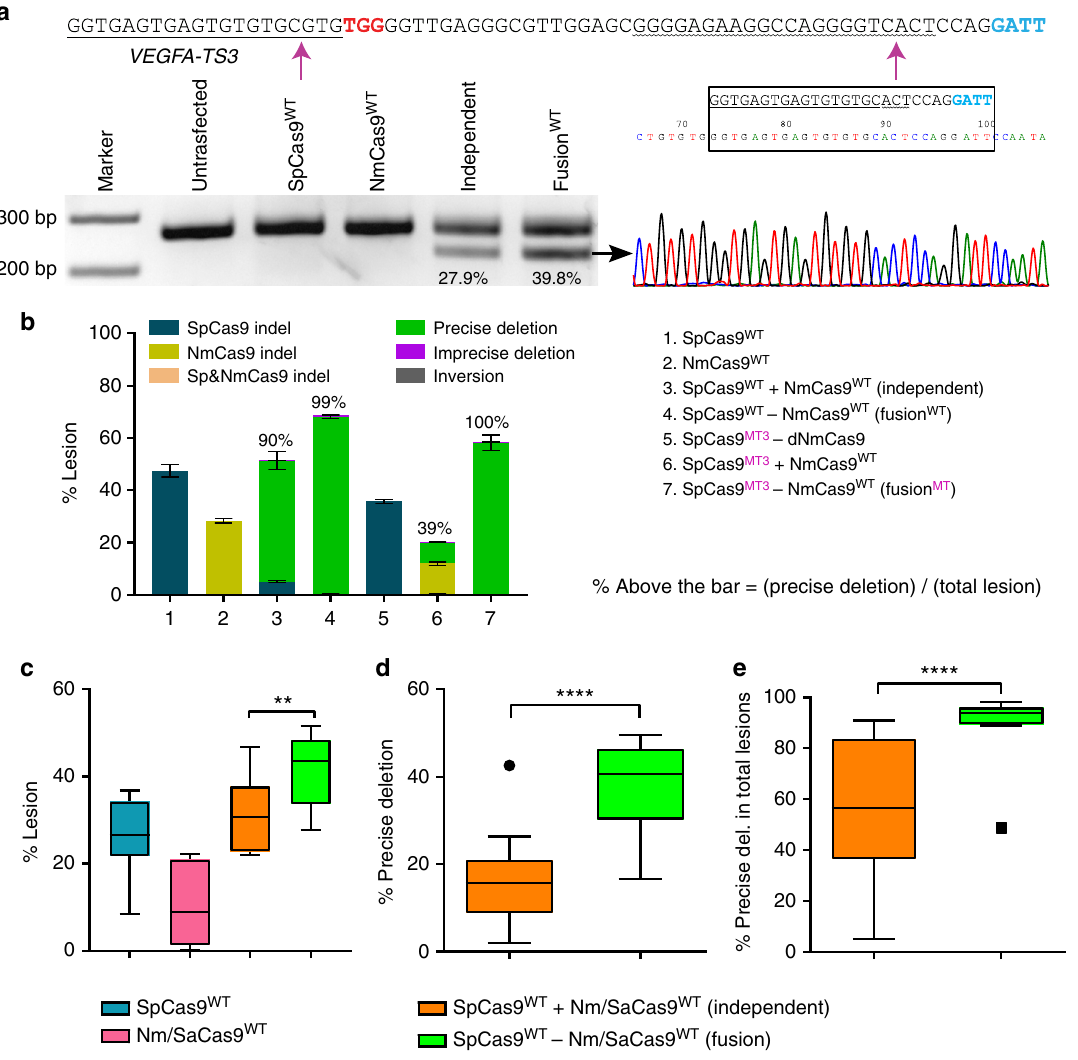
Fig. 3 Cas9 – Cas9 dual nucleases generate uniform deletion products. a Top, sequence of SpCas9-NmCas9 target site: SpCas9 protospacer is underlined and its PAM is red; NmCas9 protospacer is wavy underlined and its PAM is blue. Purple arrows indicate expected double-strand break positions. Bottom left, genomic region containing the target site is PCR ampli fi ed; the higher band is the wild-type sequence or sequences with small indels, and the lower band is the segmental deletion product generated by dual nucleases. Bottom right, chromatogram from Sanger sequencing of the gel-extracted lower band (black arrow). The main product is the perfect junction of two double-strand break sites yielding a precise deletion (black rectangle). b Lesion rates and types are determined by deep sequencing. Single nucleases generate small indels at their cleavage sites, whereas dual nucleases (independent or fusion) may generate six types of lesion products. The majority of the lesions produced by dual-nuclease fusions is precise deletion. SpCas9 MT – dNmCas9 fusions behave like a monomeric SpCas9. Values above each bar indicate the precise deletion rate divided by the total lesions. c – e Activity pro fi les of SpCas9 WT (blue), Nm/SaCas9 WT (pink), SpCas9 WT + Nm/SaCas9 WT (orange), and SpCas9 WT − Nm/SaCas9 WT (green) nucleases at 12 genomic sites (six D1 and 6 D2 con fi gurations) determined by deep sequencing. c Total lesion rates of the Cas9 – Cas9 dual nucleases are higher than the monomeric Cas9s used in combination. d Cas9 – Cas9 fusions generate higher rates of precise deletions than two independent Cas9 monomers. e Cas9 – Cas9 dual nucleases primarily generate precise deletion products whereas lesion types of the two independent monomeric Cas9s are site dependent. Each box plot is drawn by GraphPad Prism, where the box represents the 25th and 75th percentile and the middle line is the median. Whiskers and outliers are de fi ned by the Tukey method. Statistical signi fi cance is determined by one-way analysis of variance (ANOVA), ** and **** denote P < 0.01 and P < 0.0001, respectively. Deep sequencing data are from three independent biological replicates performed on different days in HEK293T cells (Supplementary Data 1). Error bars indicate ±